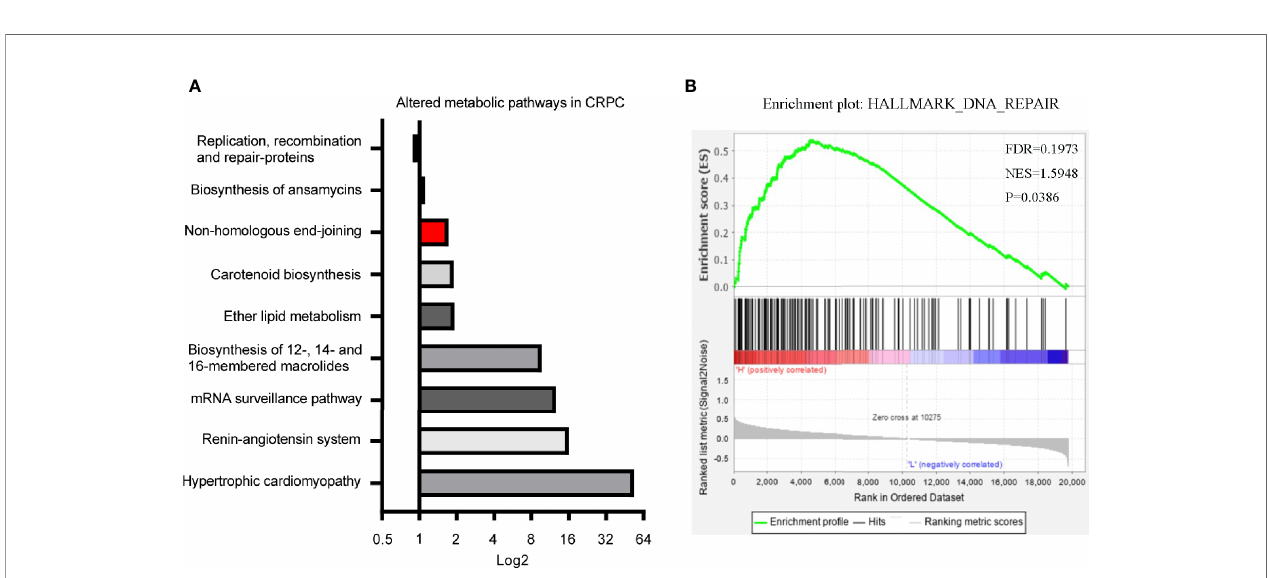
FIGURE 6 | Differentiated microbial functions and LPCAT1 GSEA analysis. (A) PICRUSt (Phylogenetic Investigation of Communities by Reconstruction of Unobserved States) identi fi ed 11 microbial KEGG pathways that were different between CRPC and HSPC individuals, non-homologous end-joining pathway (Red Bar) was enhanced in CRPC cohort. The bar represented CRPC/HSPC ratio in relative abundance of certain KEGG pathways. (B) GSEA analysis of LPCAT1 indicated positive correlation between LPCAT1 ampli fi cation status and DNA repair pathways. Cancer Genome Atlas (TCGA) data regarding prostate cancer patients was used. Through comparison between mRNA expression and LPCAT1, patients were separated into LPCAT1 high-expression group and LPCAT1 low-expression group. GSEA (Software GSEA_4.1.0.) was performed to identify enriched signaling pathways associated with LPCAT1 expression, gene sets with p value < 0.05, false discovery rate (FDR) < 0.25 were considered signi fi